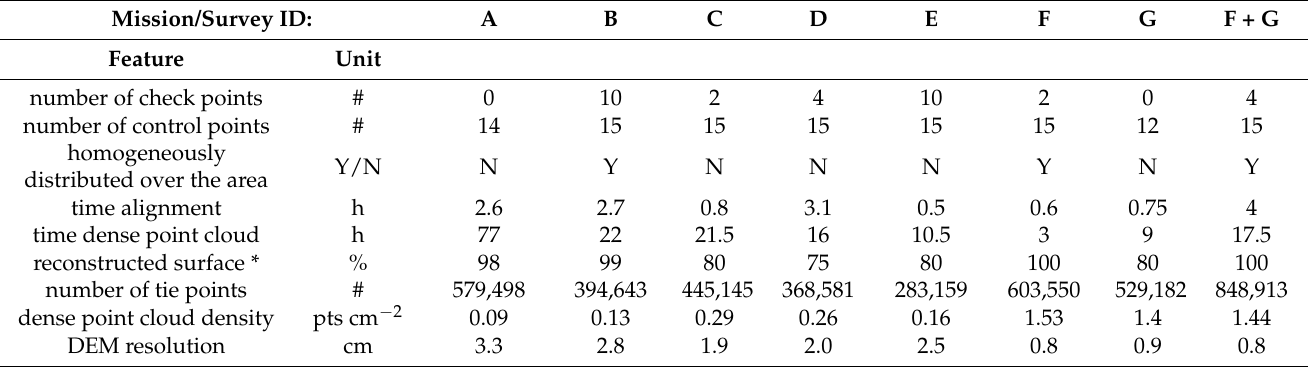
Table 2. Features of the processed SfM-UAV topographies listed in Table